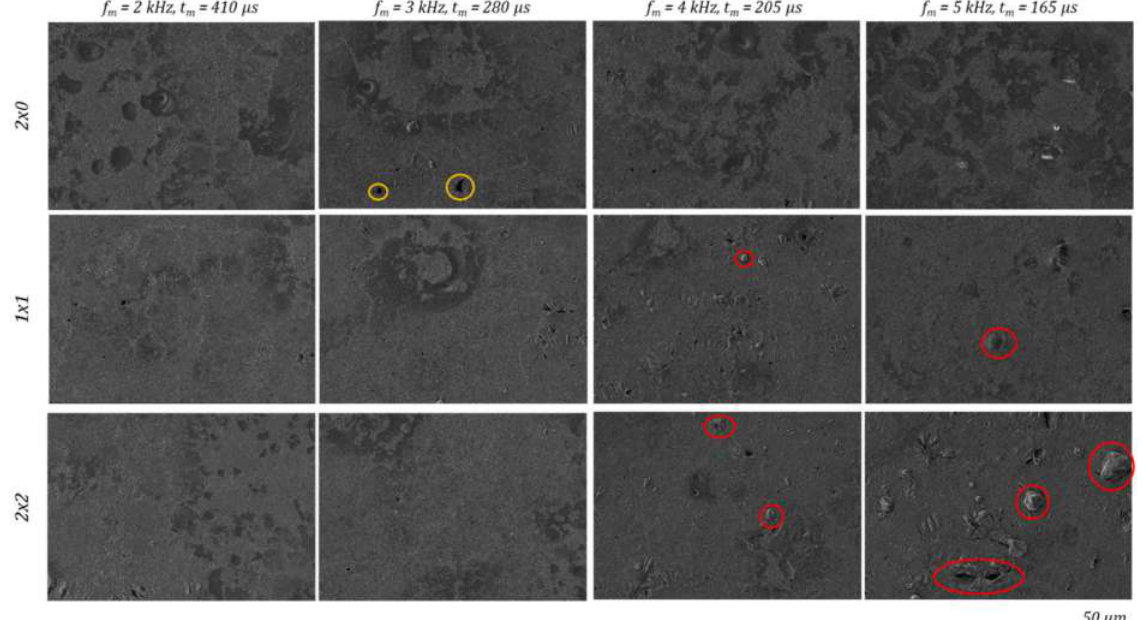
Figure 25. SEM images taken in the centre of the polishing fields at multiple polishing passes under 500-fold